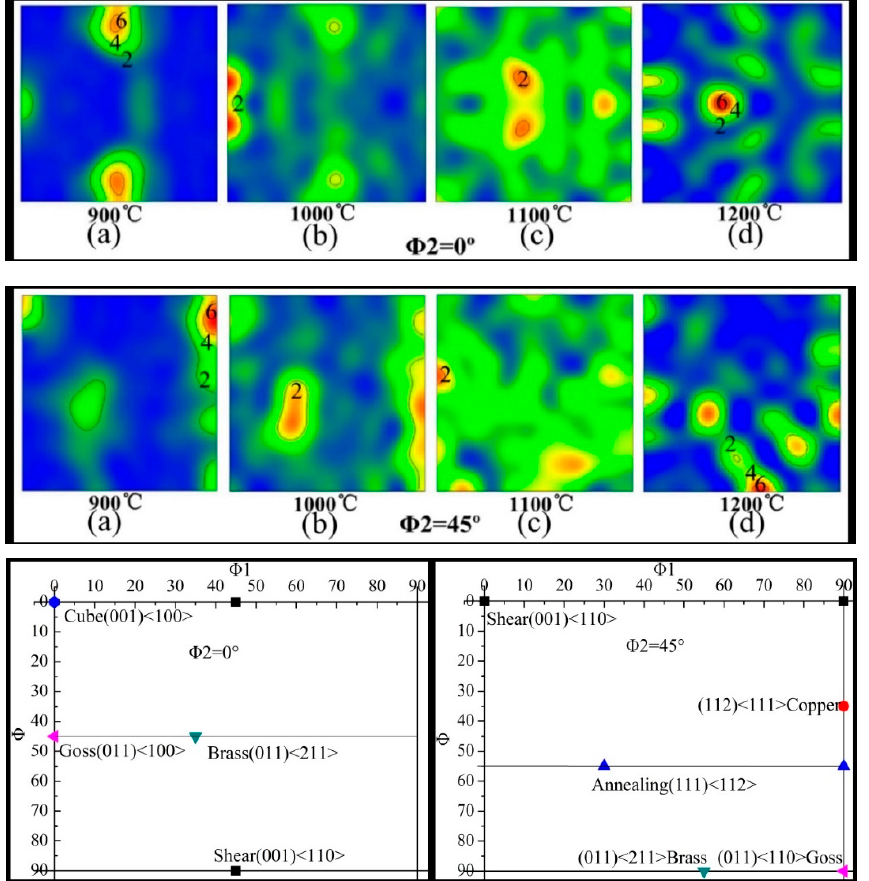
Figure 11. The orientation distribution figures (ODFs) of Inconel625 alloy at different temperatures. ( a ) 900 °C; ( b ) 1000 °C; ( c ) 1100 °C; ( d ) 1200 °C.